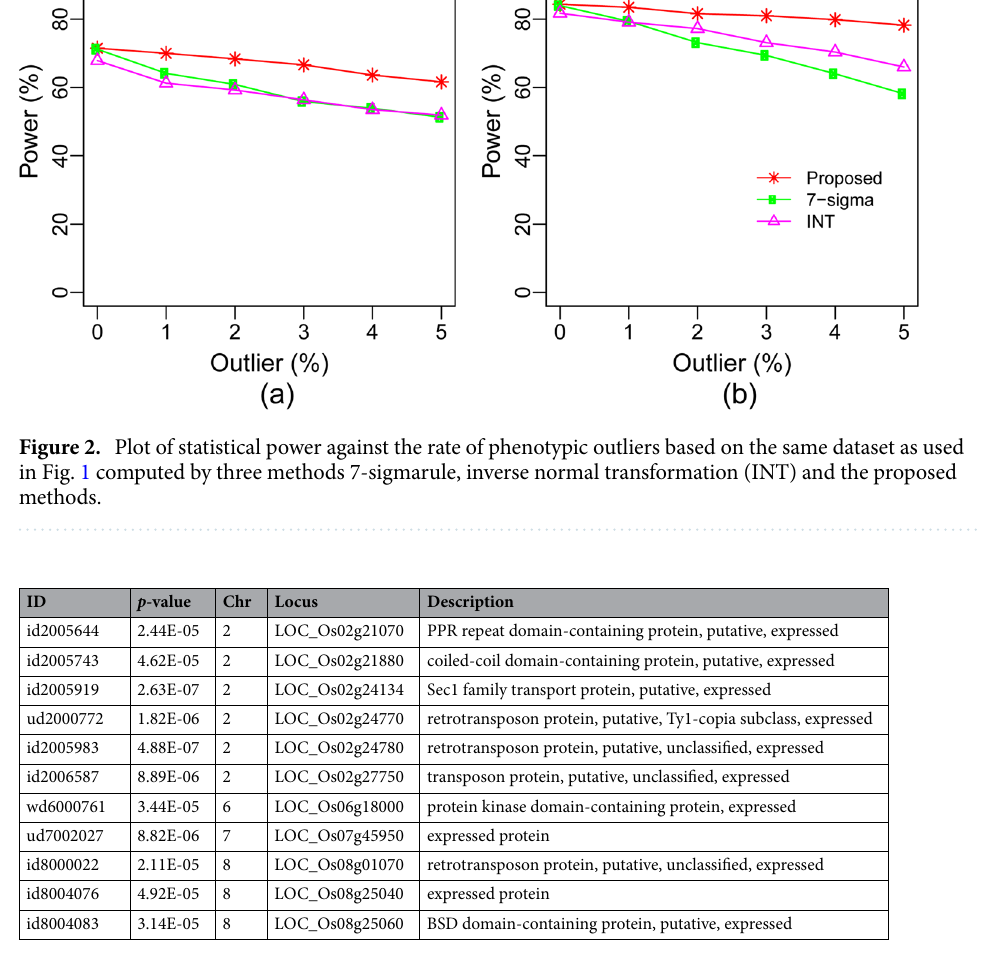
Table 2. Identified 11 SNPs and the candidate genes of rice flowering